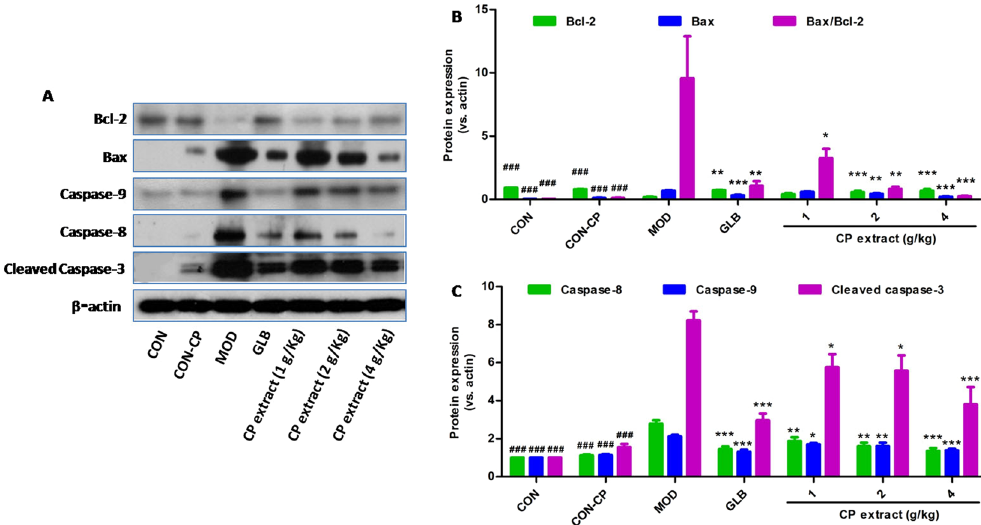
Figure 4. CP extract suppresses Bax/Bcl-2 ratio, caspase-8, Caspase-9 and cleaved caspase-3 in pancrease tissues of diabetic mice. The type 2 diabetic mice were induced by feeding with high-fat diet for 4 weeks and then injecting intraperitoneally with 25 mg/kg STZ for 3 days consecutively. The diabetic mice with consecutive 7-day hyperglycemia (11 mmol/L or greater) were selected for the experiment and then CP extract or glibenclamide were administered to mice for consecutive 5 weeks. At the end of experiment, mice were sacrificed. The samples of pancreas tissues were collected. Protein expressions of Bcl-2, Bax, caspase-8, Caspase-9 and cleaved caspase-3 were determined in pancreas tissues using Western blot. ( A ) Representative image of Western blot; ( B ) Protein expressions of Bcl-2, Bax and Bax/Bcl-2 ratio; ( C ) Protein expressions of caspase-8, Caspase-9 and cleaved caspase-3. All data are presented as means ± SEM (n = 8). # p < 0.05, ## p < 0.01 and ### p < 0.001, diabetic model group compared with non-diabetic groups; * p < 0.05, ** p < 0.01